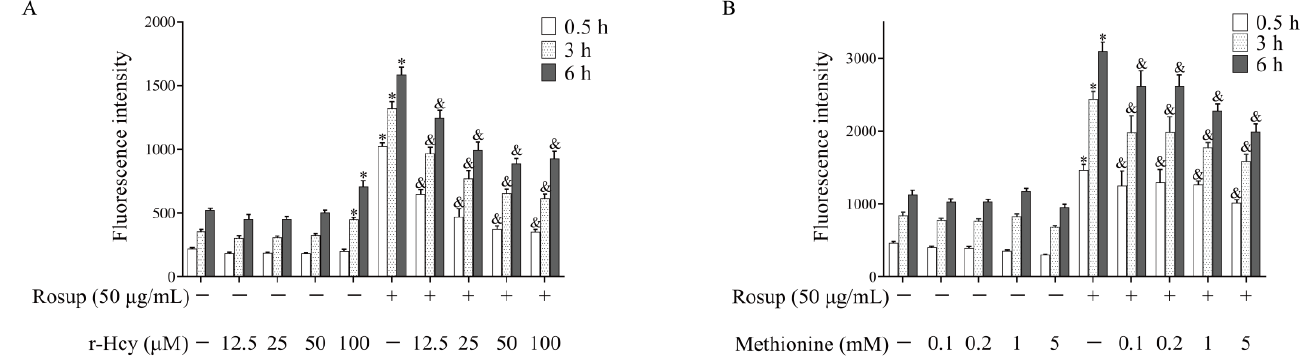
Figure 2. The effects of r-Hcy and methionine on ROS production in Rosup-treated erythrocytes. Incubation of Rosup- treated erythrocytes with 12.5~100 μM r -Hcy ( A ) and 0.1~5 mM methionine ( B ) for 0.5~6 h could significantly decrease ROS level in a concentration-dependent manner ( n = 6). * p < 0.05 vs. control group (the group without Rosup, r-Hcy, or methionine treatment), & p < 0.05 vs. Rosup group (Rosup treatment alone).